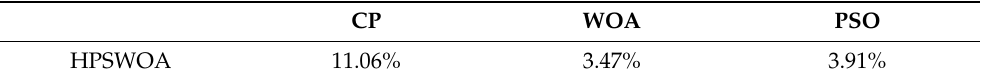
Figure 5. Scatter plot of the best total cost obtained from Table 6. Table 9. Average percentage change of the objective function from the best solution obtained from the